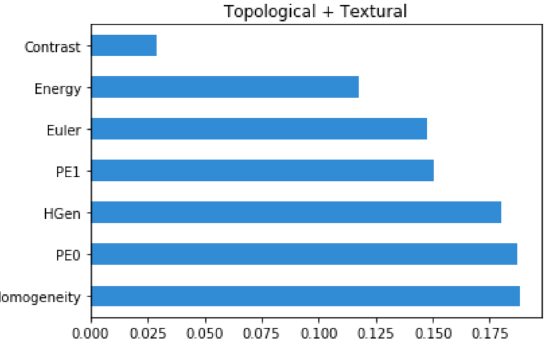
Figure 16. Global features relevance analysis w.r.t TPOT